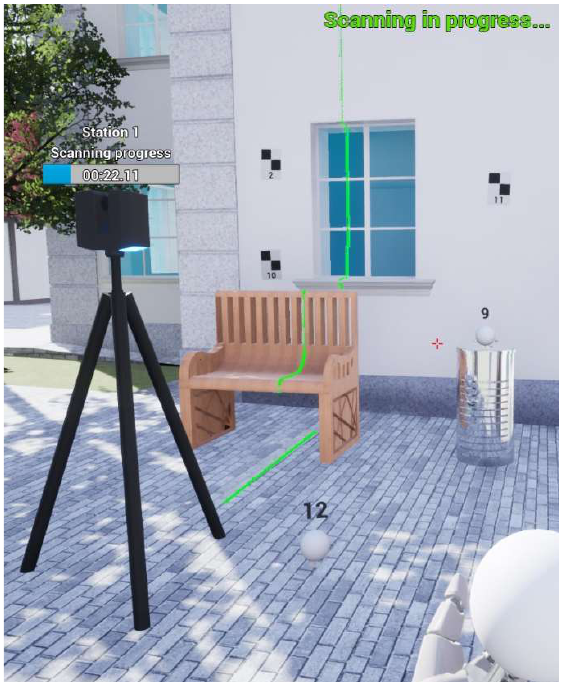
Figure 4. Simulator environment example with scanner and different types of targets.